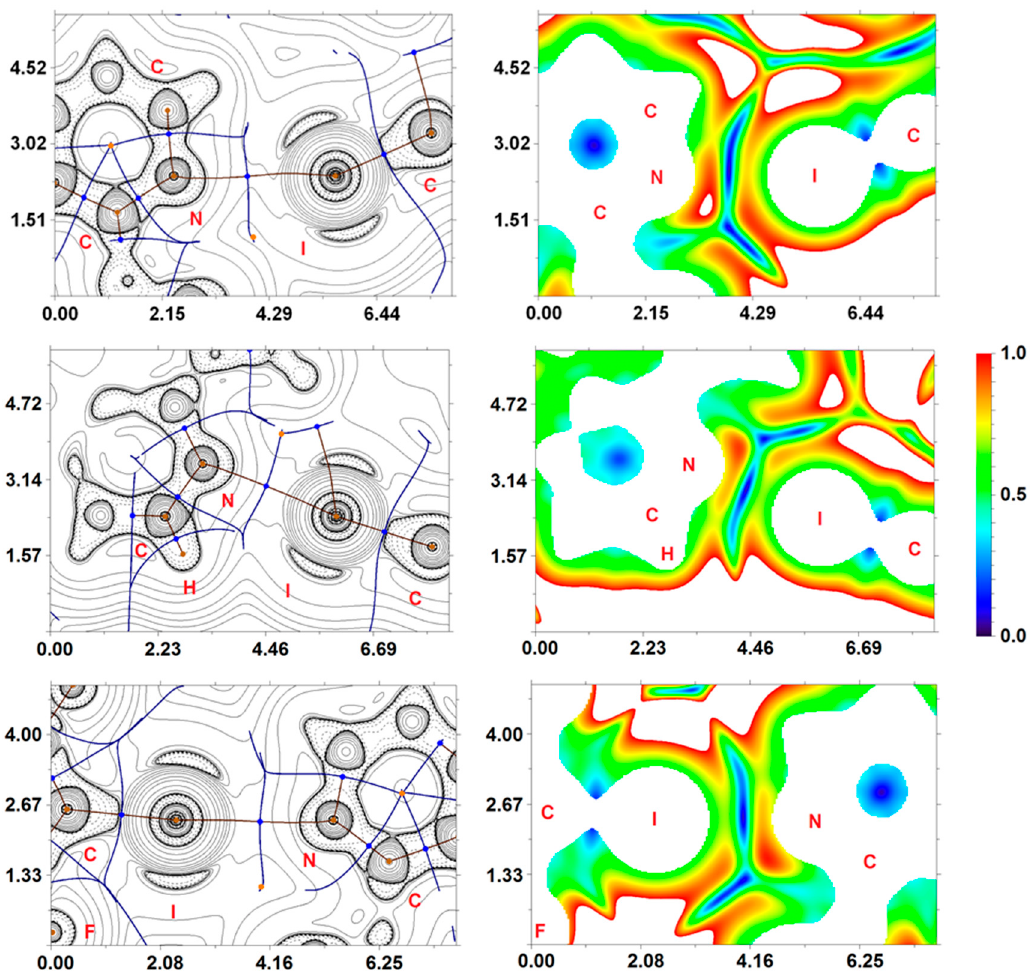
Figure 3. Contour line diagrams of the Laplacian distribution ∇ 2 ρ ( r ), bond paths and selected zero-flux surfaces (left), and RDG isosurfaces (right) referring to the C–I···N XBs in (NVP) 3 ·(1,3-DIB) 3 (upper) and (NVP) 4 ·(1,4-FIB) 3 (middle and lower). Bond critical points (3, − 1) are shown in blue, nuclear critical points (3, − 3) in pale brown, ring critical points (3, +1) in orange. Length units—Å, RDG isosurface values are given in a.u.